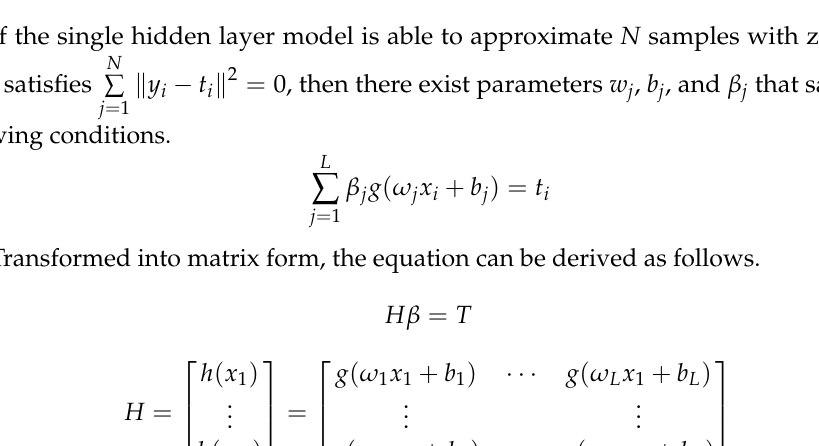
Figure 1. Extreme learning machine network structure.